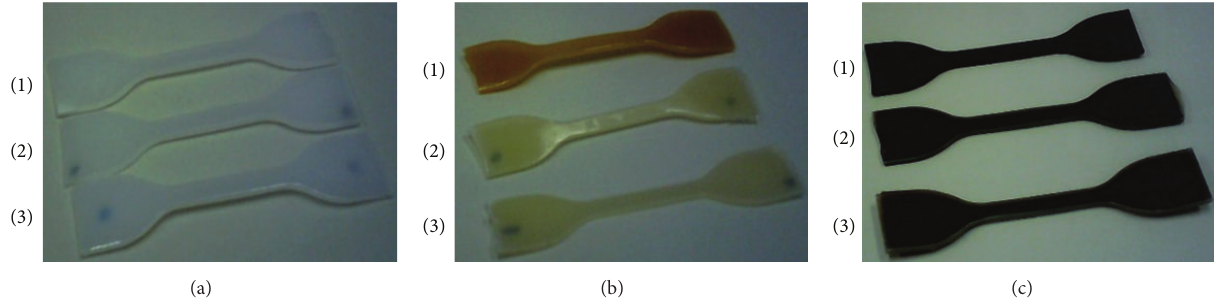
Figure5:(1)Unexposedspecimens,(2)exposedspecimensfor21daystoUVradiation,and(3)exposedspecimenfor42daystoUVradiation: (a) neat UHMWPE, (b) UHMWPE with annatto, and (c) UHMWPE with beet.